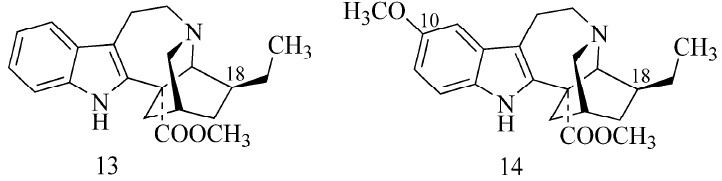
Figure 5. Chemical structures of coronaridine ( 13 ) and voacangine ( 14 ).